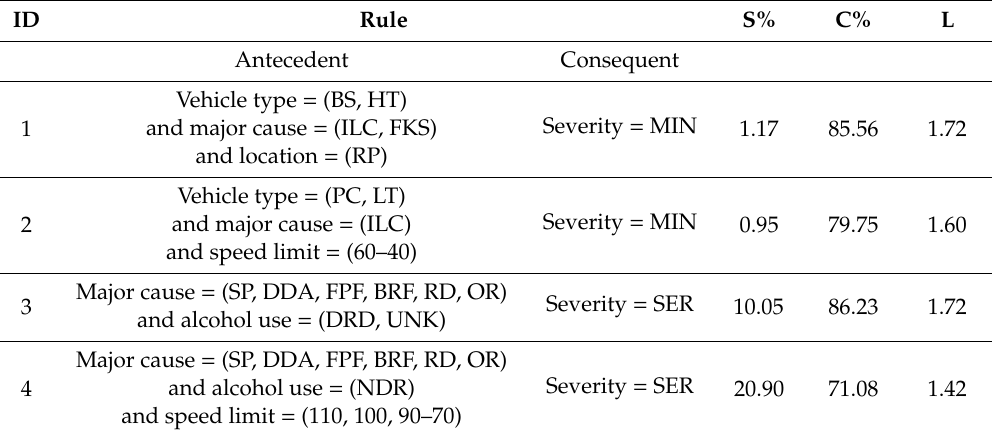
Table 9. Rules converted from tree graph as the output of